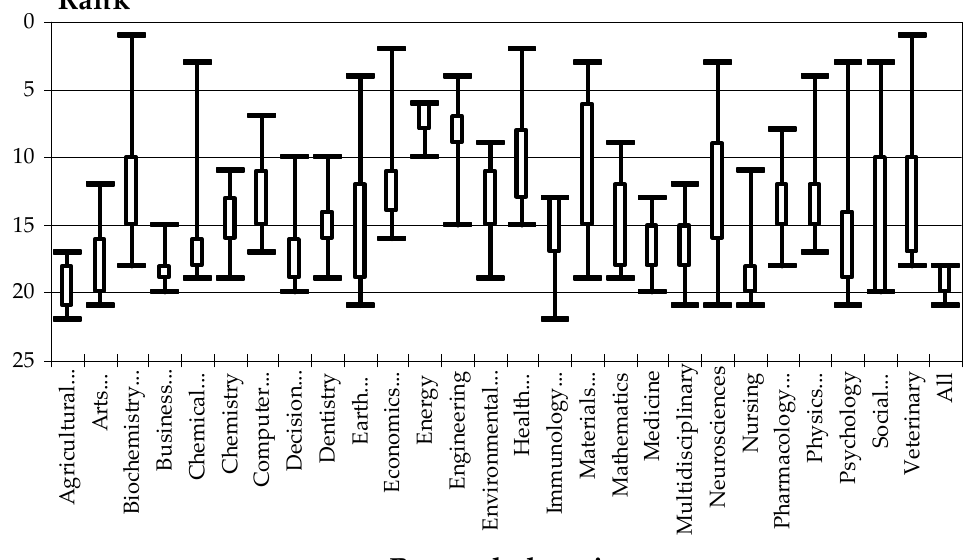
Figure 14. The visibility of articles published in di ff erent fields in Romania during 2010–2018, measured based on the adjusted number of citations per document. The figure displays boxplots based on the ranks of the fields computed for each year separately. Results indicate a huge variability and pinpoint an overall poorer performance, with important fluctuations.